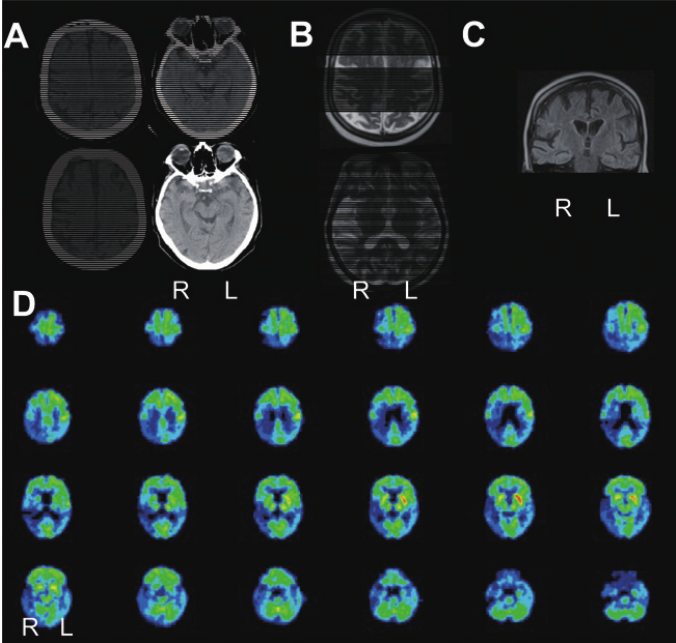
Fig. 2. [A] Right parietal atrophy on the fi rst CT-scan when she was 67 y.o. (top) progressing to the right frontal regions including prefrontal cortex, motor cortex and frontal poles on both sides after 5 years (bottom), without any signi fi cant hippocampal atrophy. [B] T2-MRI at the age of 66 showing right perisylvian/right insula atrophy. [C] Coronal plane of FLAIR-MRI showing absence of signi fi cant hippocampal atrophy [D] Hypometabolism in the right hemisphere on 18F-FDG PET-scan (performed when she was 72 y.o.), extending from the parietal to frontal, temporal and occipital lobes, as well as right thalamus, putamen, pallidum and caudate nucleus; those changes are particularly severe posterior to the right sensorimotor cortex in the parietal lobe including both superior and inferior parietal lobules, right posterior insula and the adjacent right parietal opercule. All views are axial slices except [C]. R = right; L = left. (Colours are visible in the online version of the article;